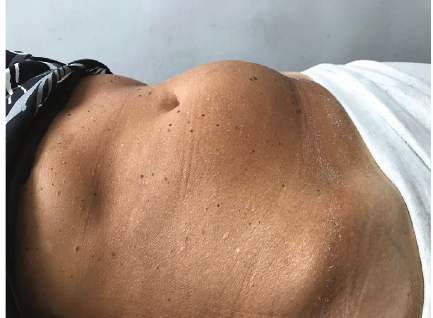
Figure 1: Deformation of the abdominal area.